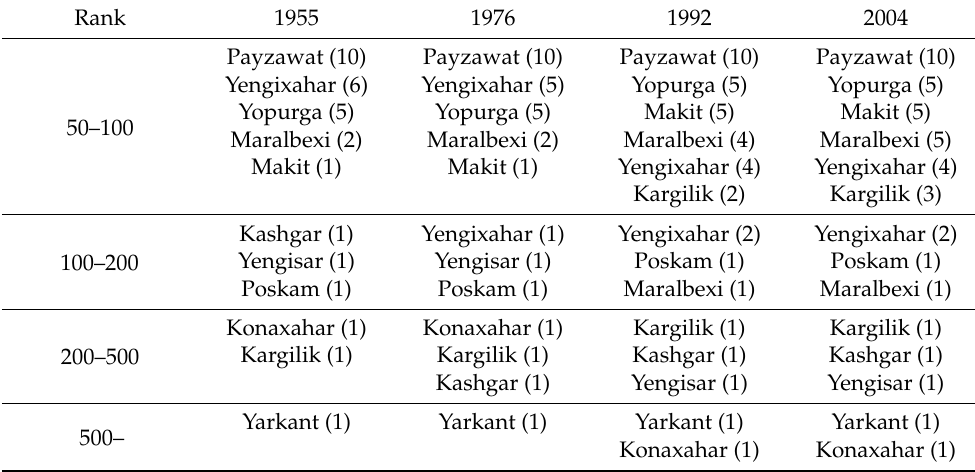
Table 4. SDE data for the spatial distribution of mosques in the Kashgar region from 1955 to 2004.